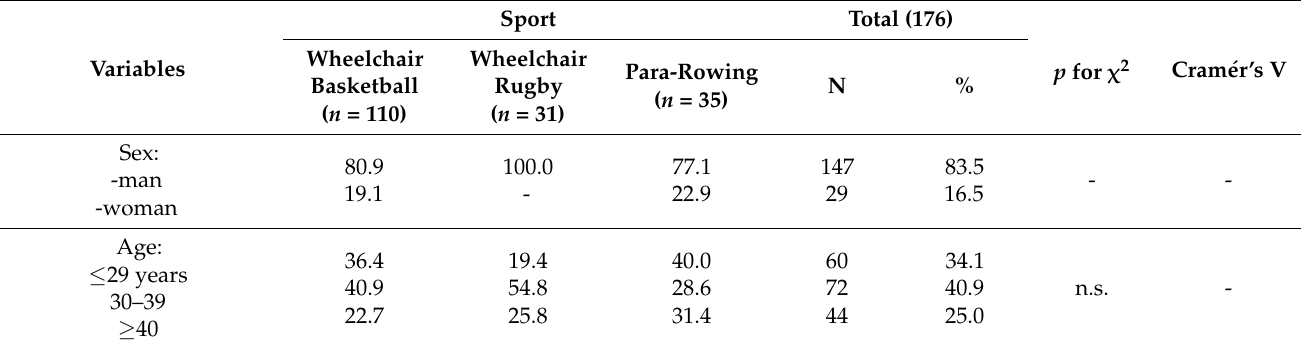
Table 1. Socioeconomic characteristics of people practicing wheelchair basketball, wheelchair rugby and para-rowing (independence χ 2 test and Cram é r’s